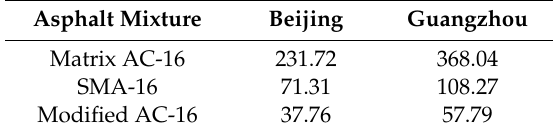
Table 4. Prediction of annual rut depth in special tra ffi c areas of Beijing and Guangzhou (unit: mm).